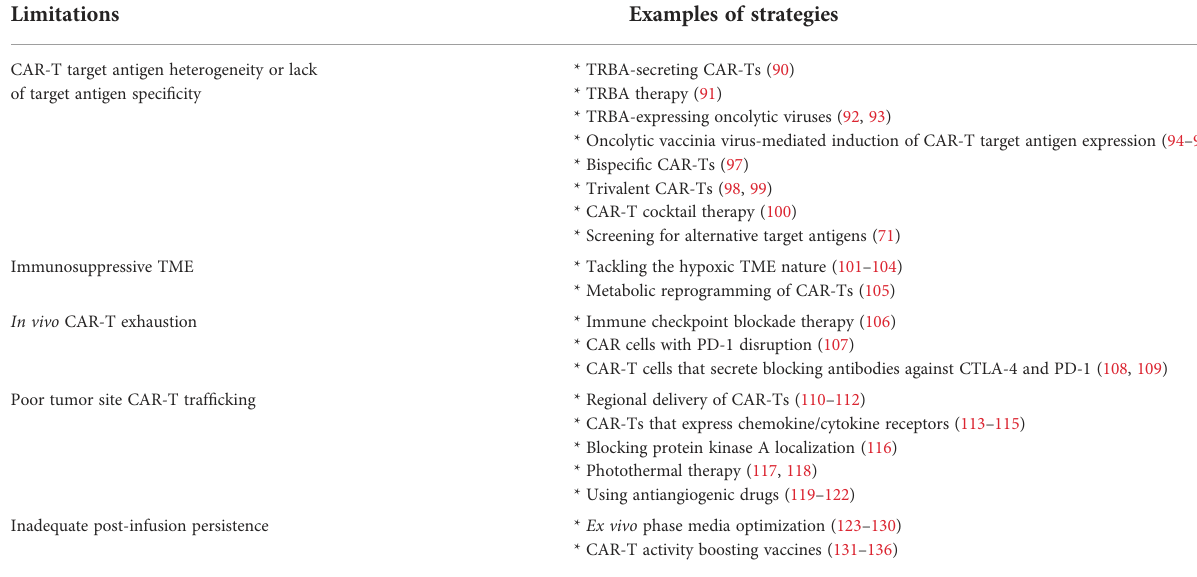
TABLE 2 Signi fi cant limitations related to CAR-T therapy of solid tumors and examples of strategies to tackle these challenges. Limitations Examples of